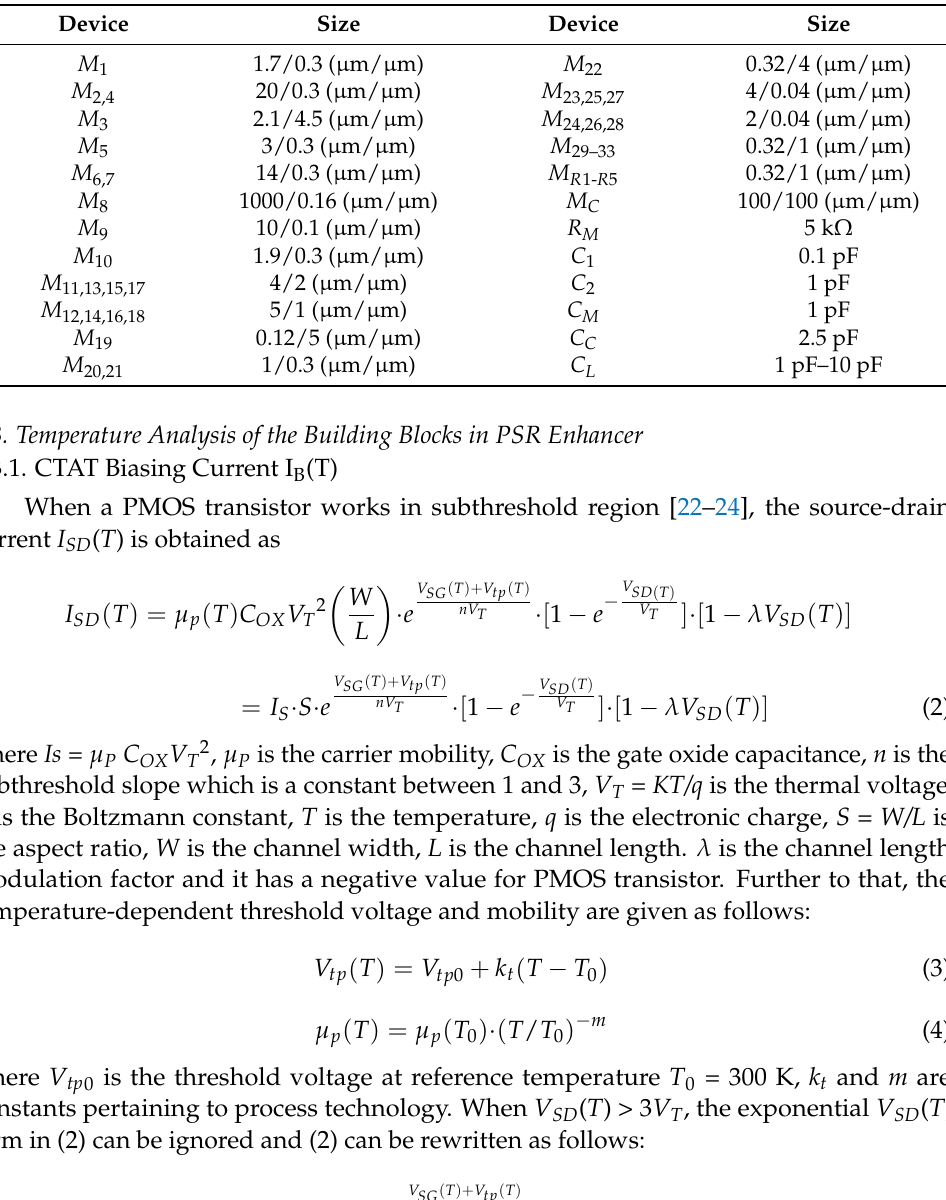
Table 2. Sizes of the devices in the proposed